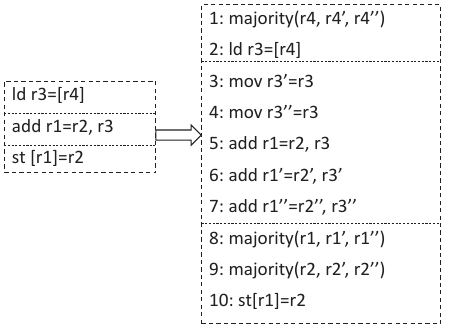
Figure 4. An example of